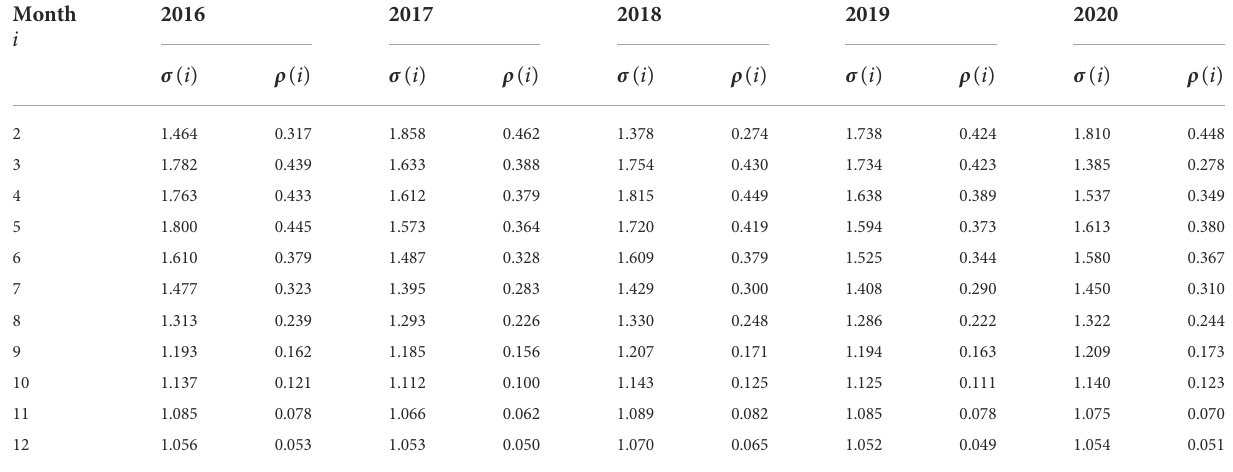
TABLE 4 Original sequence grade ratio and smoothness ratio